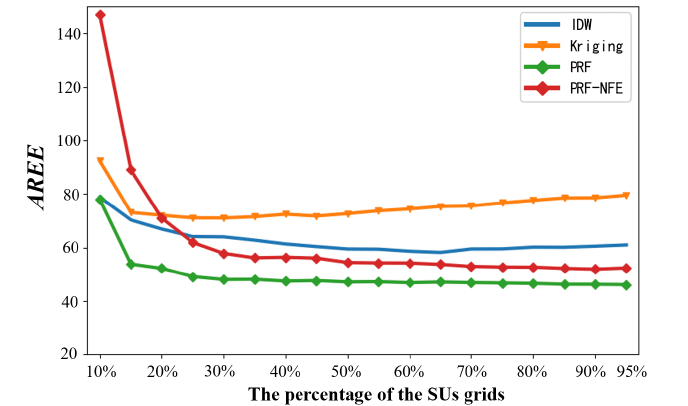
Figure 13. The average REMs estimating error against different numbers of secondary